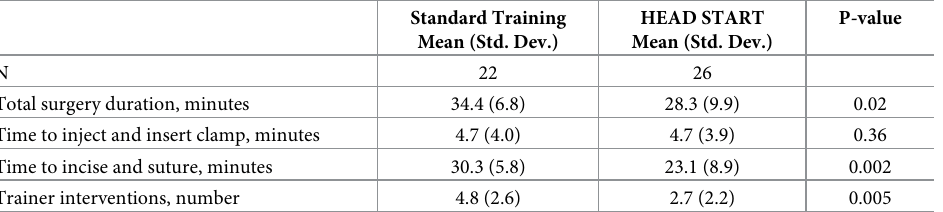
Table 1. Characteristics of First Training Surgeries According to Training